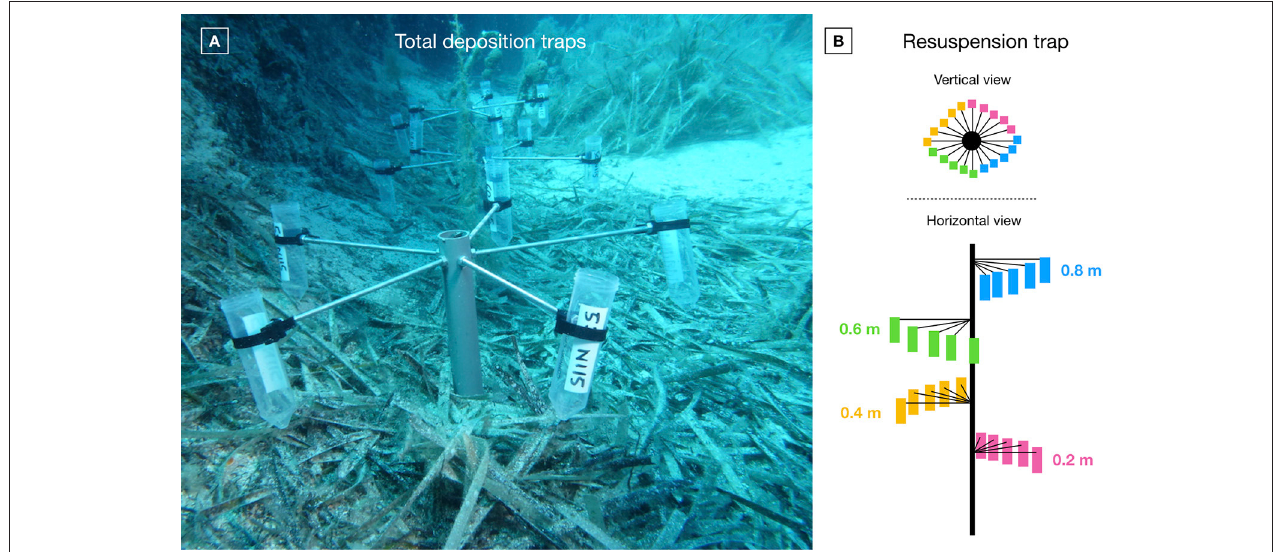
FIGURE 4 | (A) Total deposition traps in a natural patch (photo: A. Abadie); (B) Schematic vertical and horizontal views of a resuspension trap.